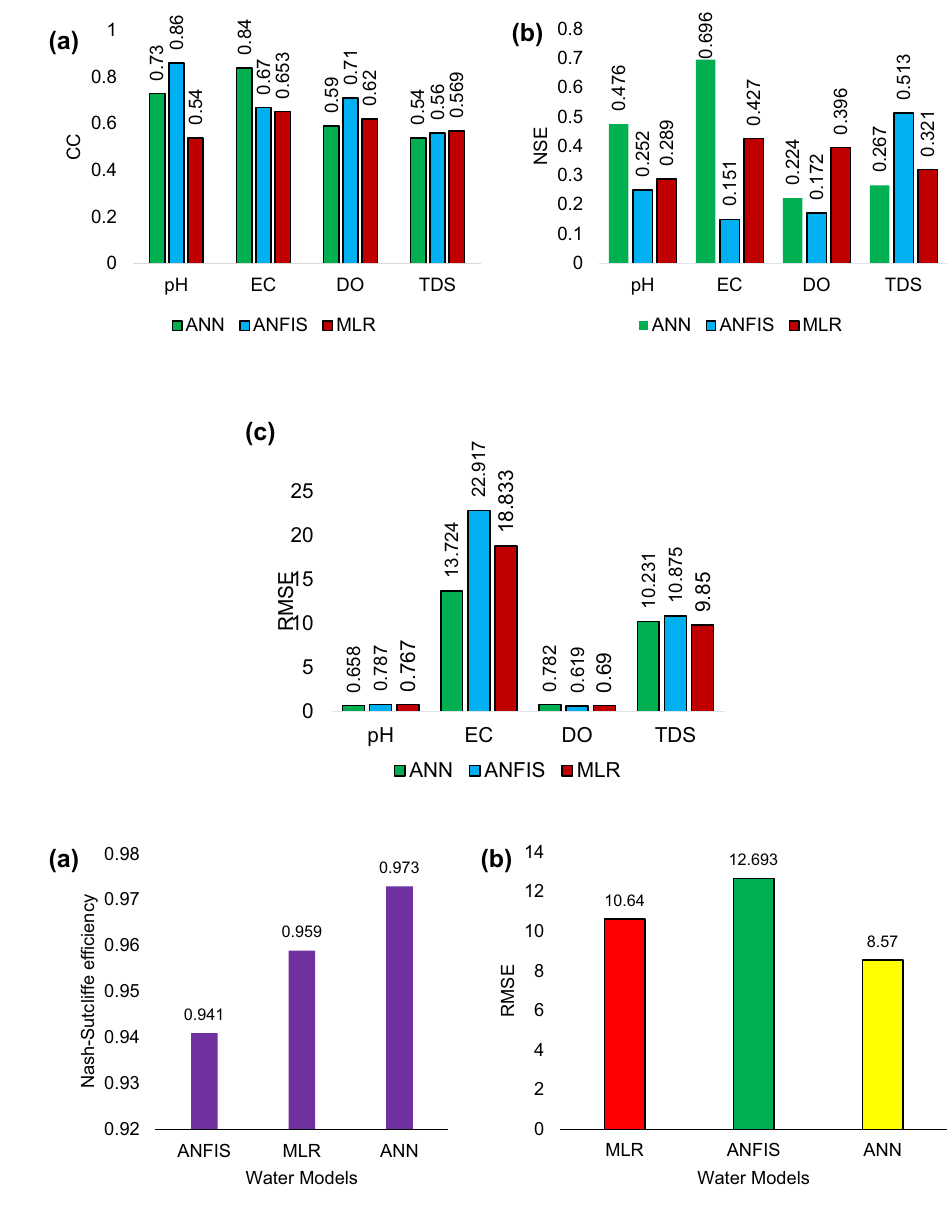
Fig. 9 a Overall Nash–Sutcliff efficiency; b overall root mean square error by the